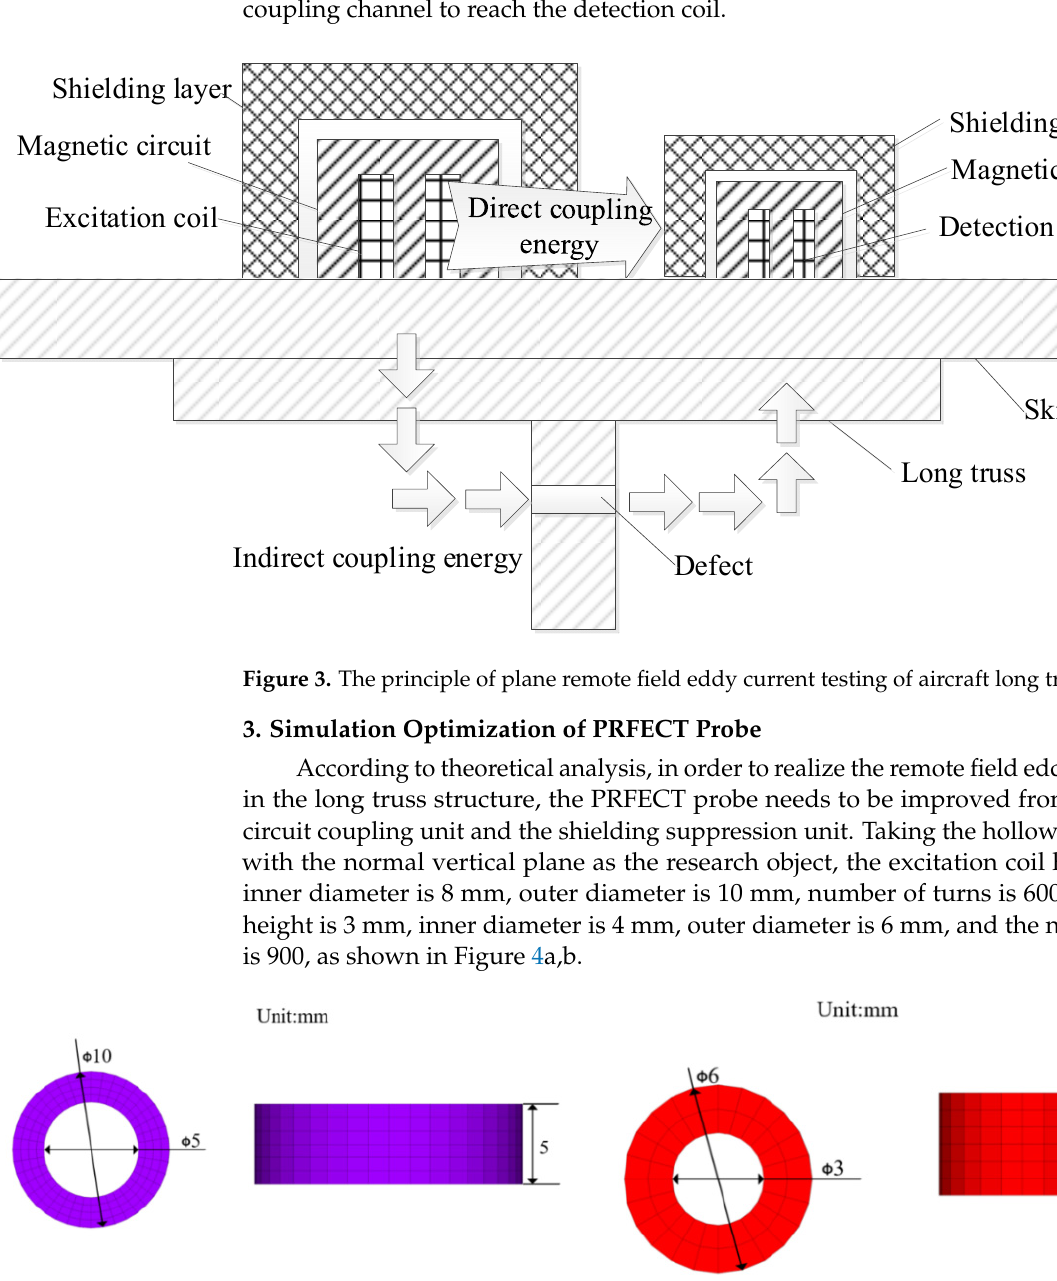
Figure 4. Coil size diagram. ( a ) Excitation coil; ( b ) Detection coil. First, a simulation model of long truss members without defects is established. The model is mainly composed of a T-shaped long truss structure and skin. The size of the skin is 200 mm (length) × 180 mm (width) × 3 mm (thickness), the flange of the T-shaped long truss structure is 200 mm (length) × 80 mm (width) × 2 mm (thickness), and the web part is 200 mm (length) × 50 mm (width) × 3 mm (thickness), as shown in Figure 5.